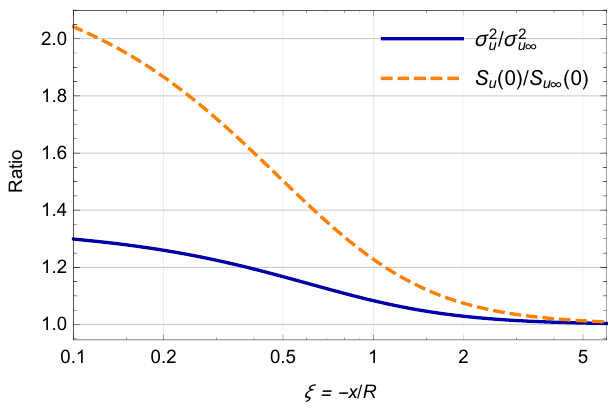
Figure 1. Amplification of the low-frequency spectrum and vari- ance of longitudinal turbulence in the center of the rotor plane ac- cording to rapid distortion theory in the limit at which the length scale of the turbulence is much smaller than the rotor radius. The induction factor is a = 1 /